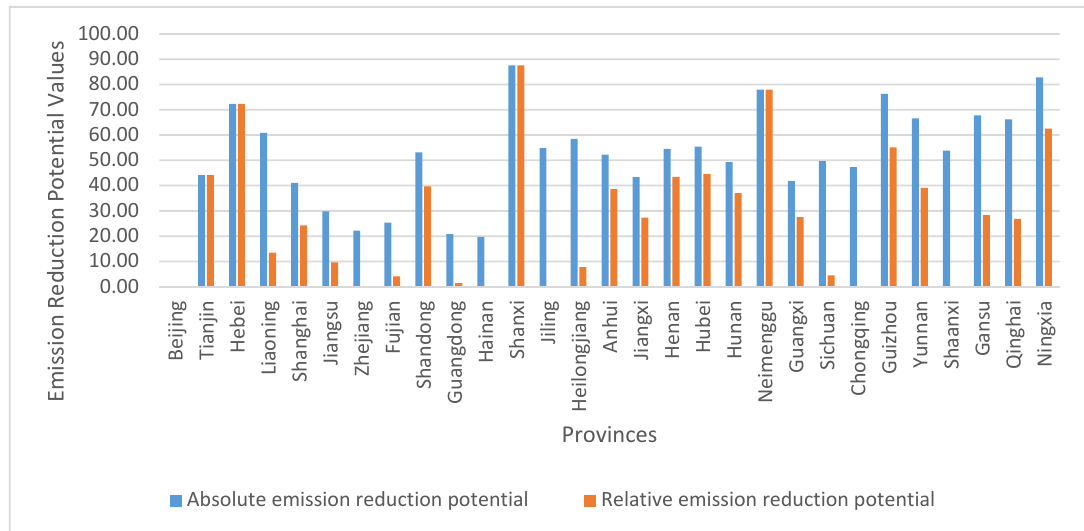
Figure 2. The future emission reduction potential of various provinces in China.